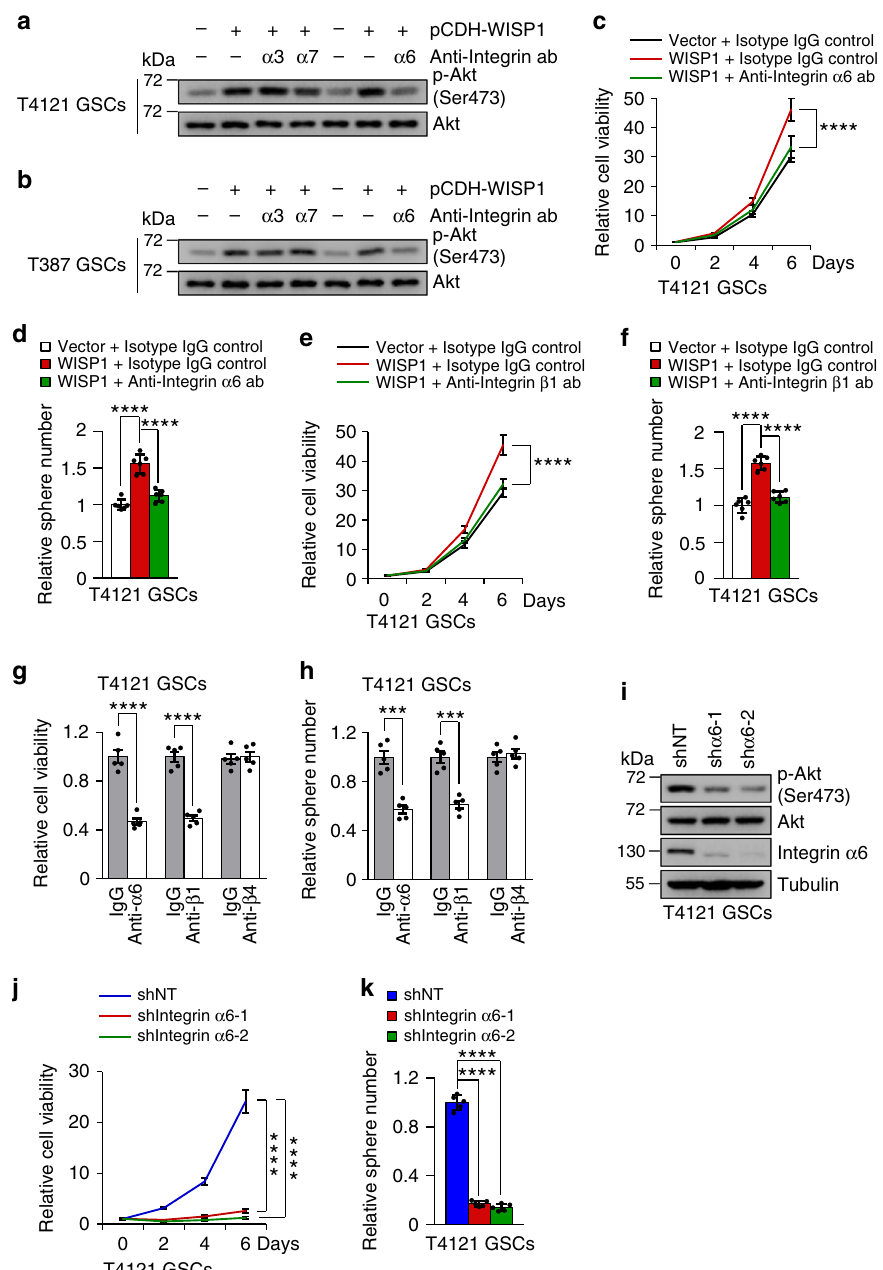
Fig. 5 WISP1 acts through Integrin α 6 β 1 to activate Akt in GSCs. a , b , Immunoblot analysis of Akt activating phosphorylation (Ser473) in T4121 GSCs ( a ) and T387 GSCs ( b ) treated with 5 μ g/ml Integrin blocking antibody (Anti-Integrin ab) or relative isotype IgG control in combination with WISP1 overexpression or vector control for 48 h. α 3, Integrin α 3; α 6, Integrin α 6; α 7, Integrin α 7. c , d , Cell viability ( c ) or tumorsphere formation ( d ) assay of T4121 GSCs treated with 5 μ g/ml Integrin α 6 blocking antibody (ab) or isotype IgG in combination with WISP1 overexpression or vector control. n = 6 biological independent samples. Data are shown as means ± s.d. **** p <0.0001, two way ANOVA analysis followed by Tukey ’ s multiple test ( c ). **** p <0.0001, two- tailed unpaired t -test ( d ). e , f , Cell viability ( e ) or tumorsphere formation ( f ) assay of T4121 GSCs treated with Integrin β 1 blocking antibody (5 μ g/ml) or isotype IgG in combination with WISP1 overexpression or vector control. n = 5 ( e ) or 6 ( f ) biological independent samples. Data are represented as mean ± s.d. **** p <0.0001, two way ANOVA analysis followed by Tukey ’ s multiple test ( e ). **** p <0.0001, two-tailed unpaired t -test ( f ). g , h , Cell viability ( g ) or tumorsphere formation ( h ) assay of T4121 GSCs treated with Integrin blocking antibody (5 μ g/ml) or isotype IgG for 6 days. n = 5 biological independent samples. Data are represented as mean ± s.d. *** p = 0.001, **** p <0.0001, two-tailed unpaired t -test. α 6, Integrin α 6; β 1, Integrin β 1; β 4, Integrin β 4. i Immunoblot analysis of Akt phosphorylation (Ser473) and Integrin α 6 expression in T4121 GSCs transduced with shIntegrin α 6 or shNT control. j , k , Cell viability ( j ) or tumorsphere formation ( k ) assay of T4121 GSCs transduced with shIntegrin α 6 or shNT. n = 5 biological independent samples. Data are shown as means± s.d. **** p <0.0001, two way ANOVA analysis followed by Tukey ’ s multiple test ( j ). **** p <0.0001, two-tailed unpaired t -test ( k ). Source data are provided as a Source data fi